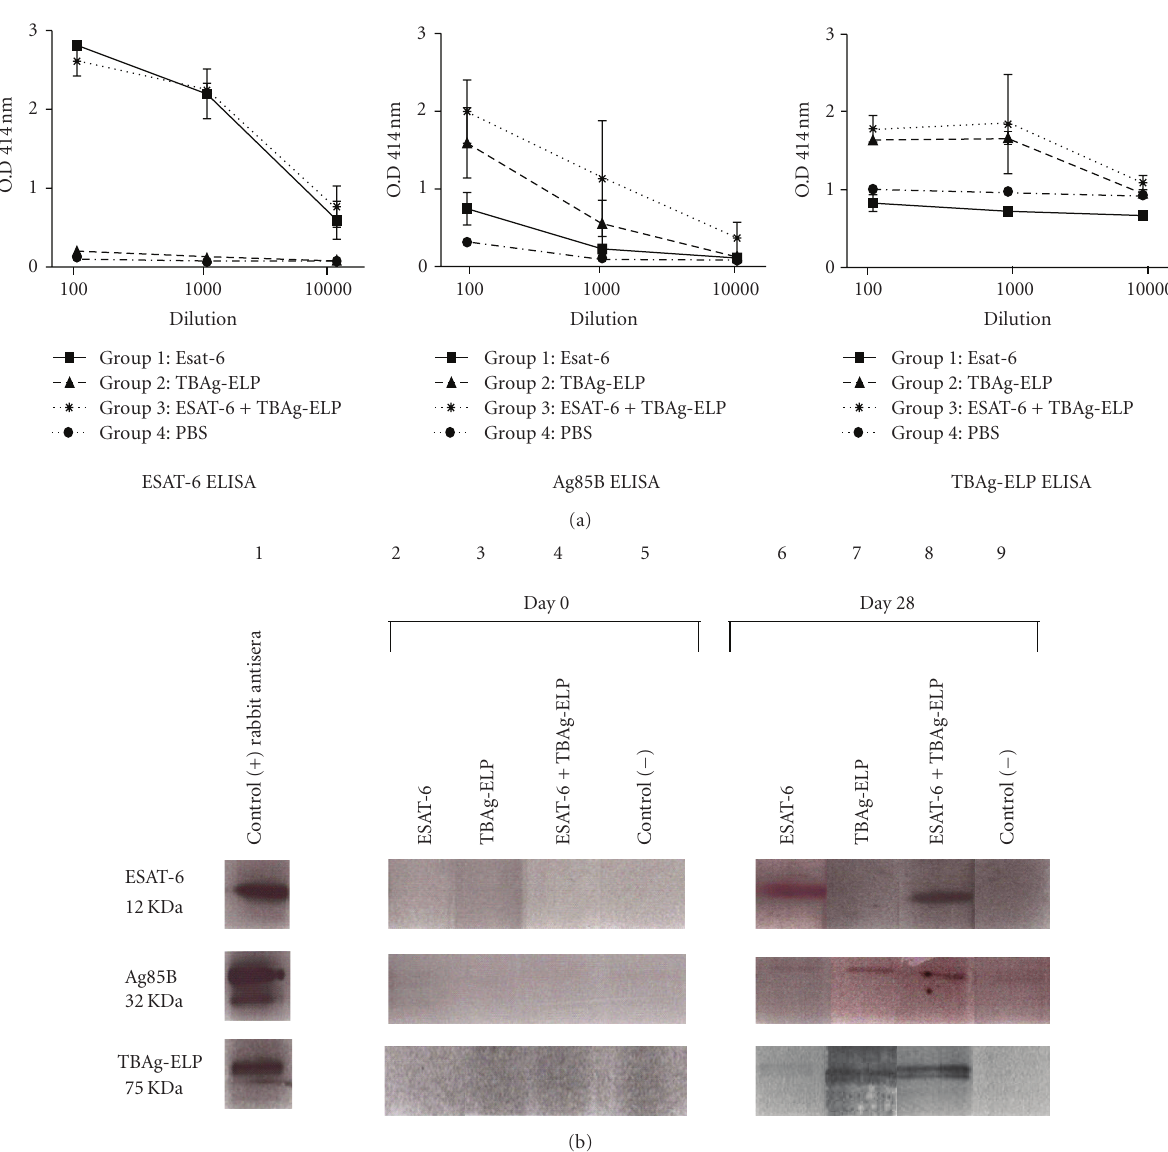
Figure 8: Assessment of the humoral response during the piglet experiment. Four groups of 2 piglets were immunized on days 0, 7, and 14 through an intradermal route. Group 1 was injected with E. coli ESAT-6, group 2 with TLE-TBAg-ELP, group 3 with E. coli ESAT-6 and boosted two times with TLE-TBAg-ELP, and group 4 received PBS, as the control. Sera were harvested weekly and diluted (10 − 2 , 10 − 3 , and 10 − 4 ). The IgG antibody response against the di ff erent TB antigens was measured by ELISA (a) and Western blot (b). (a) ELISA analysis of the piglet IgG response on day 28 against E. coli ESAT-6, Ag85B, and plant-expressed TBAg-ELP. Results represent the mean optical densities ( ± SEM, n = 2, each in triplicate). (b) Western blot analysis of the piglet antibody response on day 0 and 28. Lane 1: rabbit antisera, lanes 2 and 6: sera from piglets immunized with E. coli ESAT-6 (group 1), lanes 3 and 7: sera from piglets immunized with TLE-TBAg-ELP (group 2), lanes 4 and 8: sera from piglets sensitized with E. coli ESAT-6 and boosted with TLE-TBAg-ELP (group 3), and lanes 5 and 9: sera from control piglets receiving PBS (group